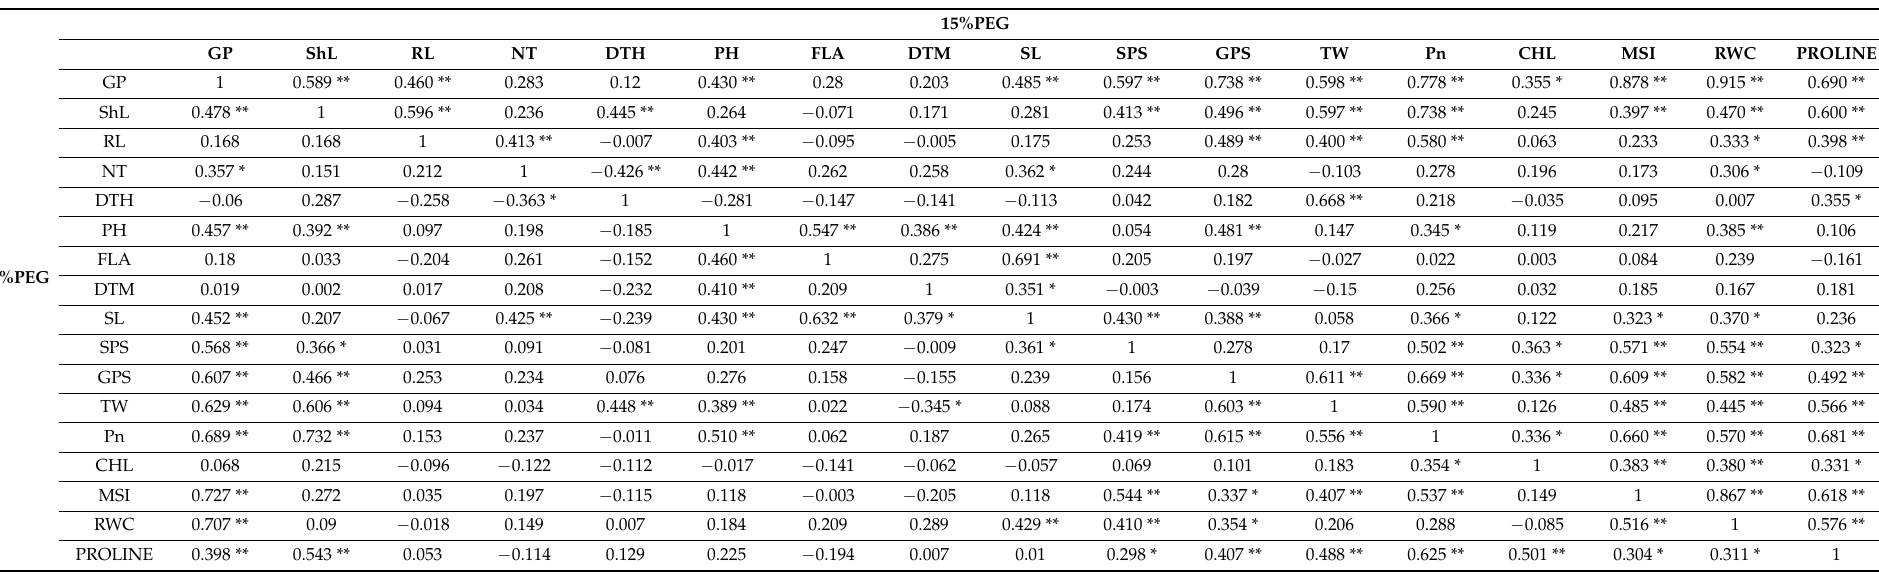
Table 6. Pearson’s correlation coefficients(r) describing association of morphological, physiological and biochemical traits of 15 wheat genotypes evaluated under drought 10% PEG (lower diagonal) and 15% PEG (upper diagonal) treatment